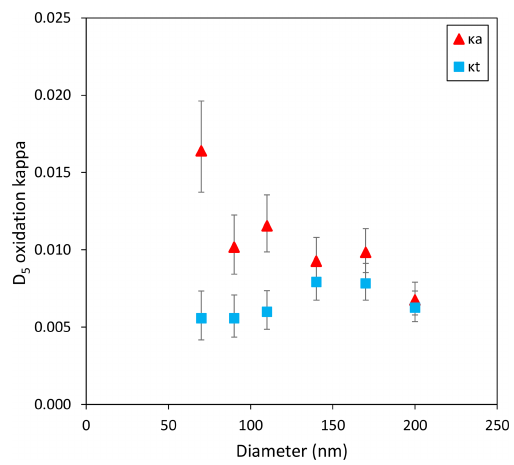
Figure 6. Size-resolved kappa parameters for D 5 oxidation aerosols. Error bars represent the 95% confidence